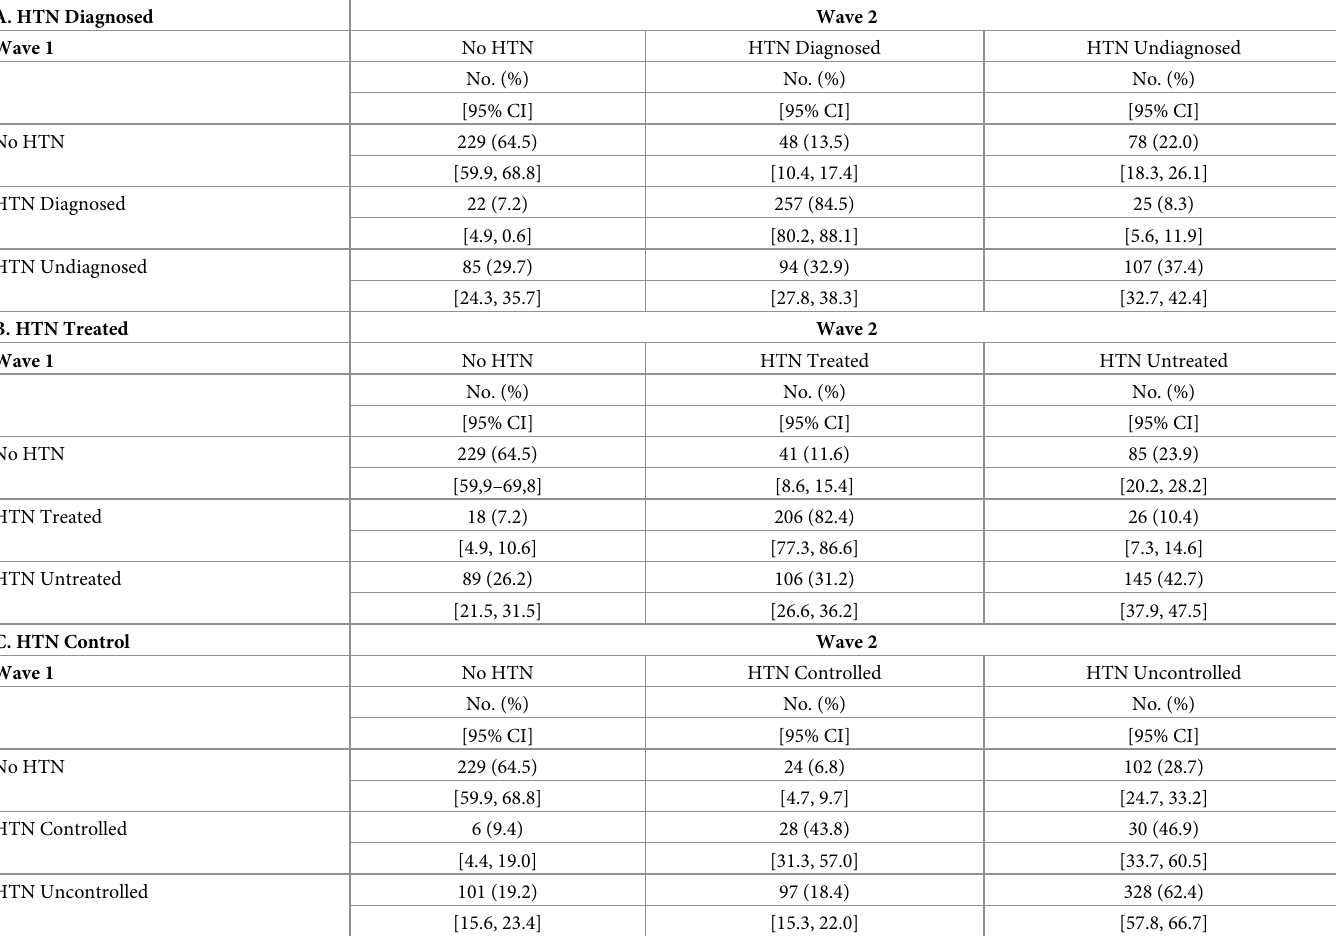
Table 4. Transitions between hypertension